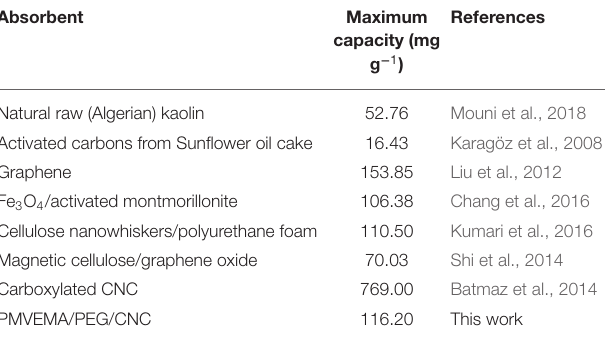
TABLE 4 | The maximum MB adsorption capacity of different